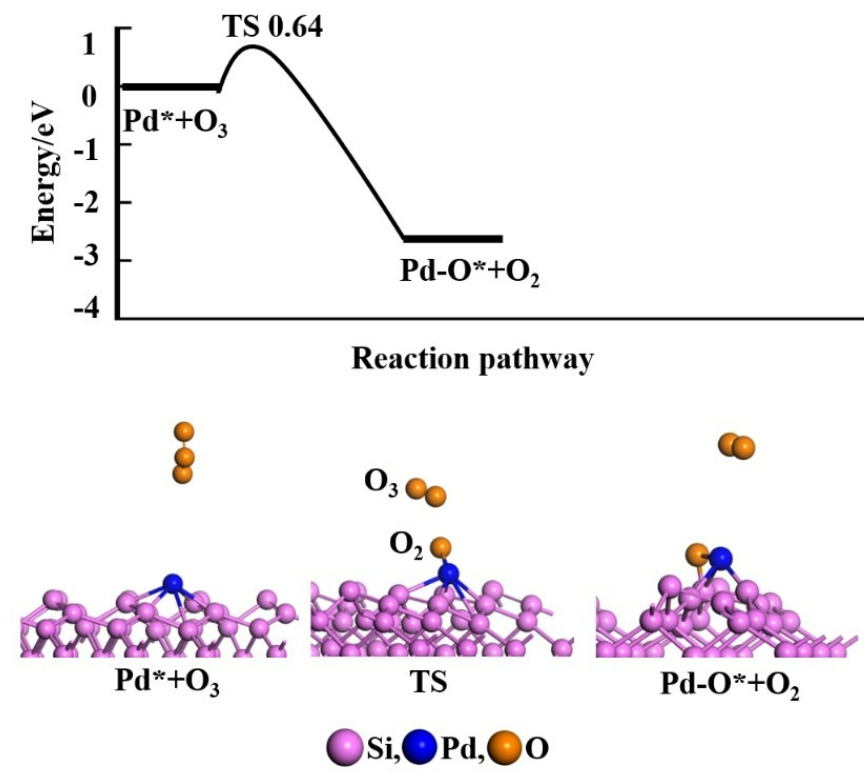
energy was − 2.64 eV. Hence, excess ozone caused the formation of PdO.